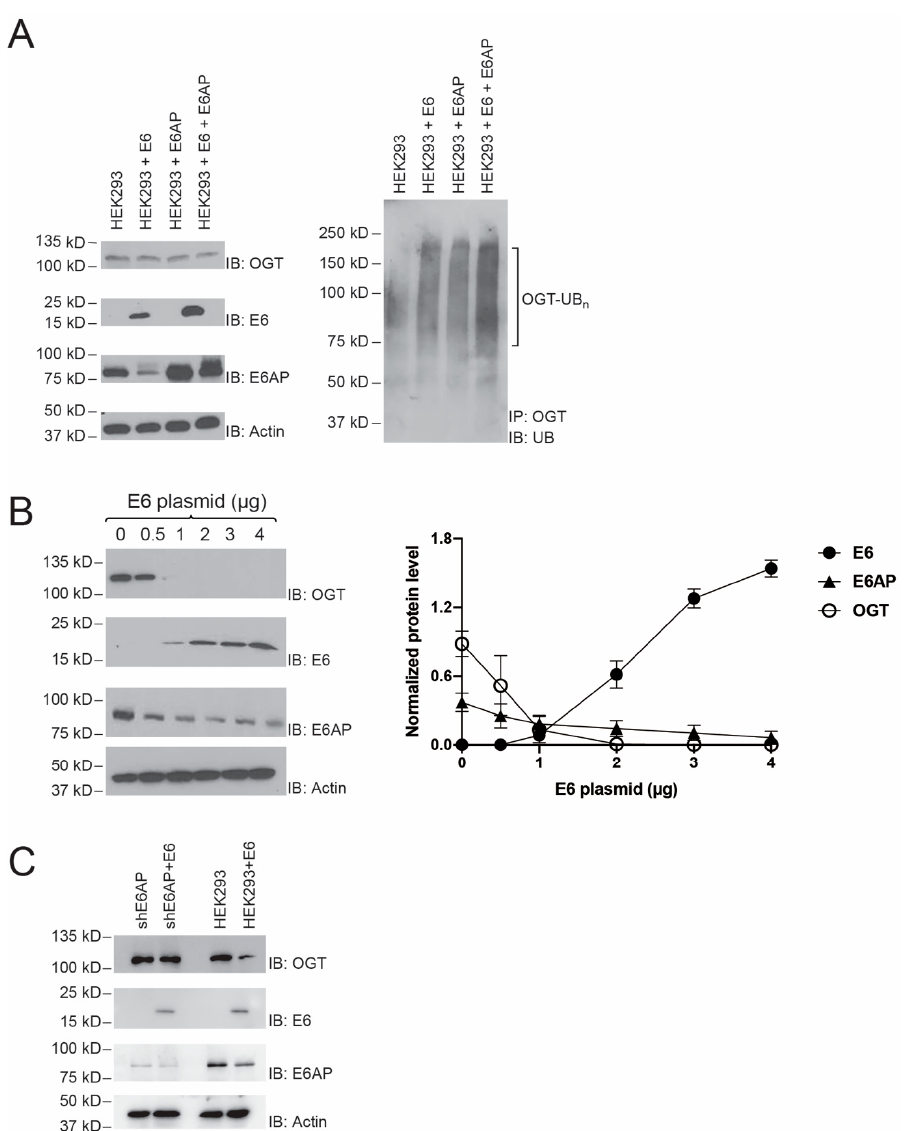
Figure 3. E6 enhanced OGT ubiquitination and degradation mediated by E6AP in HEK293 cells. ( A ) E6 enhanced OGT ubiquitination in the cells. HEK293 cells were transfected with plvx-E6AP or pLenti-E6 plasmids separately or together, and the expression of E6 and E6AP was confirmed by immunoblotting with an anti-E6 antibody or an anti-E6AP antibody (left panel). After 4 h treatment of MG132, ubiquitination of OGT was compared among blank HEK293 cells (HEK293), HEK293 cells expressing recombinant E6 (HEK293+E6), HEK293 cells expressing recombinant E6AP (HEK293+E6AP), and HEK293 cells expressing both recombinant E6AP and E6 (HEK293+E6AP+E6) (right panel). OGT ubiquitination enhanced by E6 was confirmed by the elevated ubiquitination levels of OGT in cells with co-expression of E6AP and E6. ( B ) E6 decreased the steady-state level of OGT in HEK293 cells. Cells were transfected with different amounts of E6 plasmid. Levels of OGT were assayed by immunoblotting of the cell lysate probed with an anti-OGT antibody. Quantitative analysis of OGT level in correlation with the amount of E6 expression was plotted in the panel on the right. Data points show mean ± S.E. of three or more experiments. The vertical bars in ( B ) represent SEM from three independent experiments (n = 3). ( C ) The dependence on E6AP for regulating OGT level in the cells. shE6AP and HEK293 cells were transfected with or without E6 plasmid, and levels of OGT were measured by immunoblotting with an anti-OGT